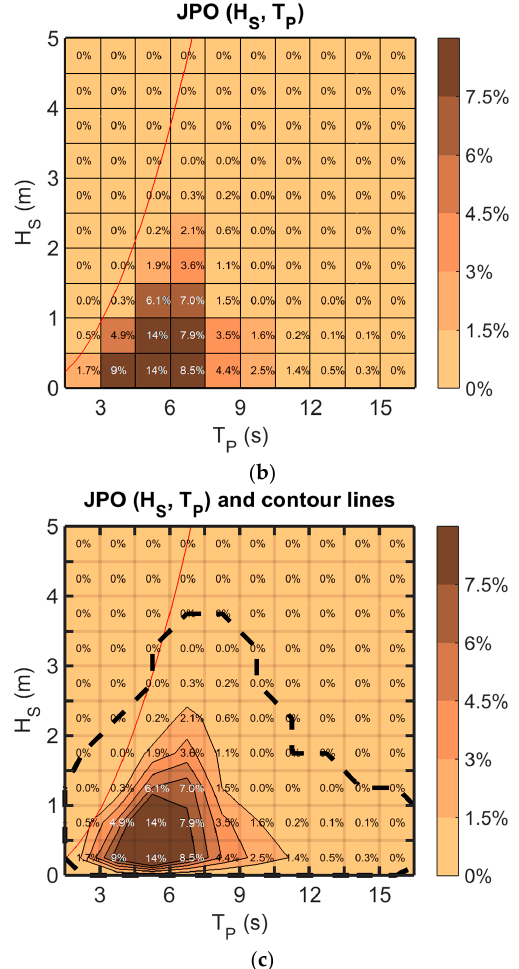
Figure 7. Examples based on the SWMFT wave data used in this paper of: ( a ) the scatter diagram, showing the number of occurrences of sea states for a given range of wave parameters H S and T P ; ( b ) the joint percentage of occurrences (JPO) of sea states for a given range of wave parameters H S and T P ; ( c ) the contour plot of JPO for wave data H S and T P . The red line corresponds to the breaking limit.